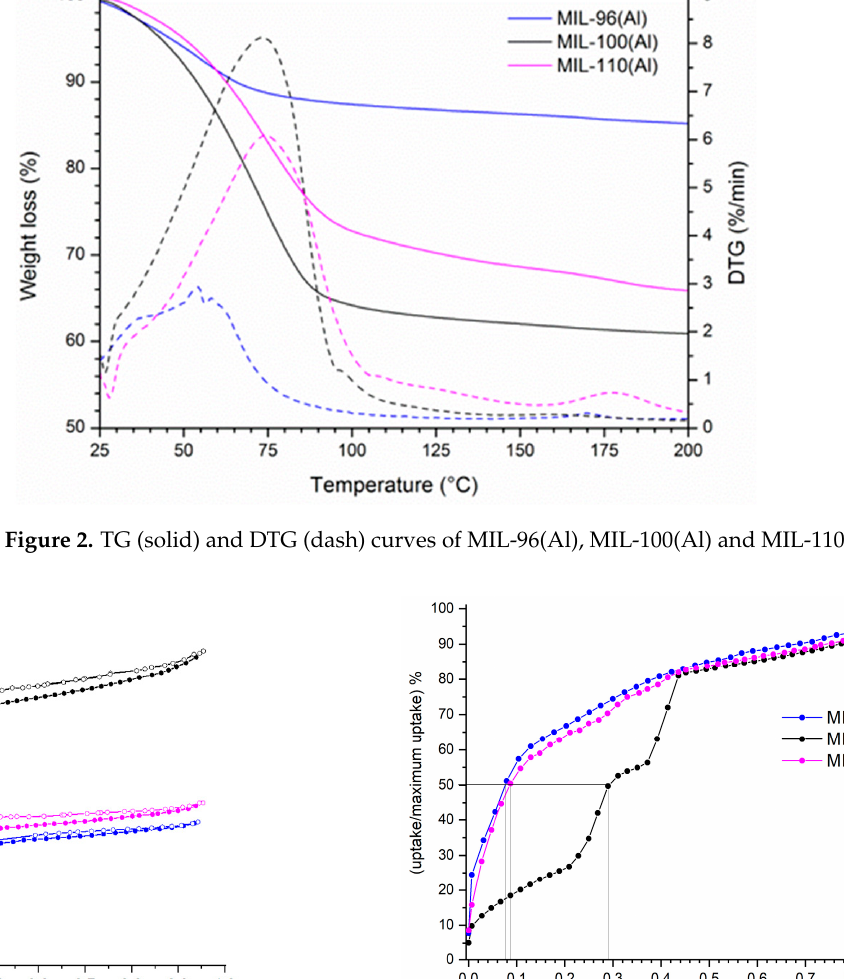
Figure 2. TG (solid) and DTG (dash) curves of MIL-96(Al), MIL-100(Al) and MIL-110(Al) materials.